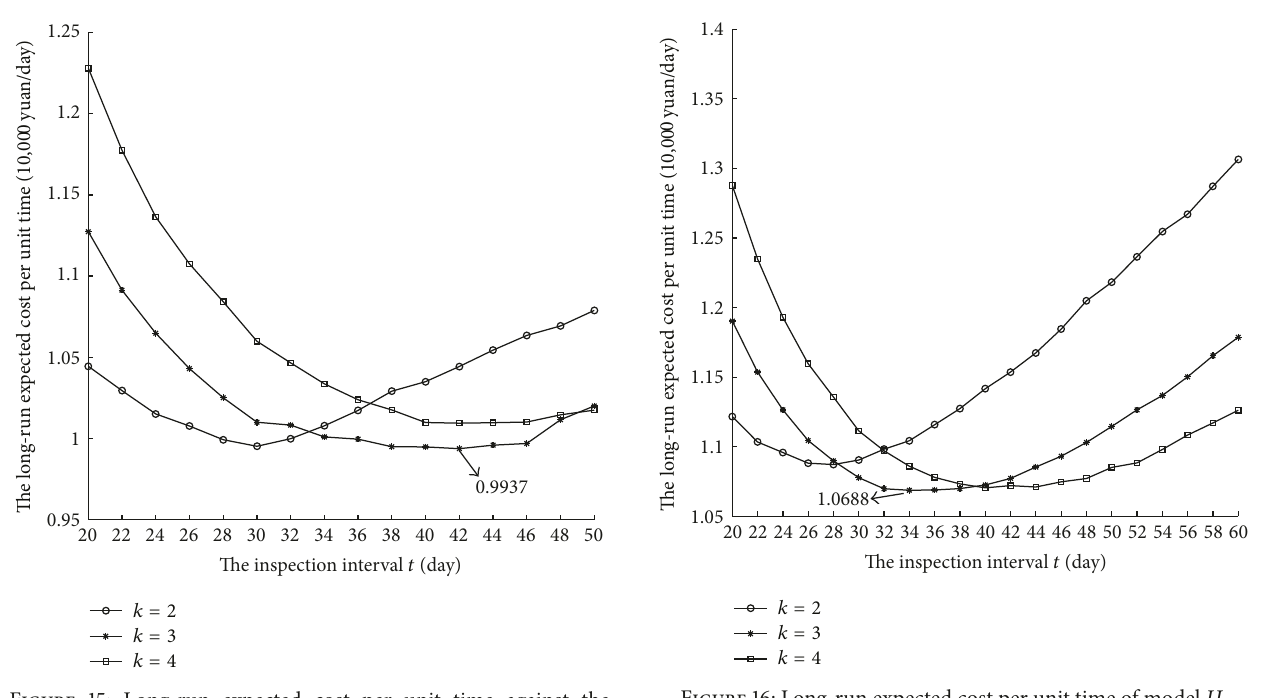
Figure 15: Long-run expected cost per unit time against the inspection interval t .